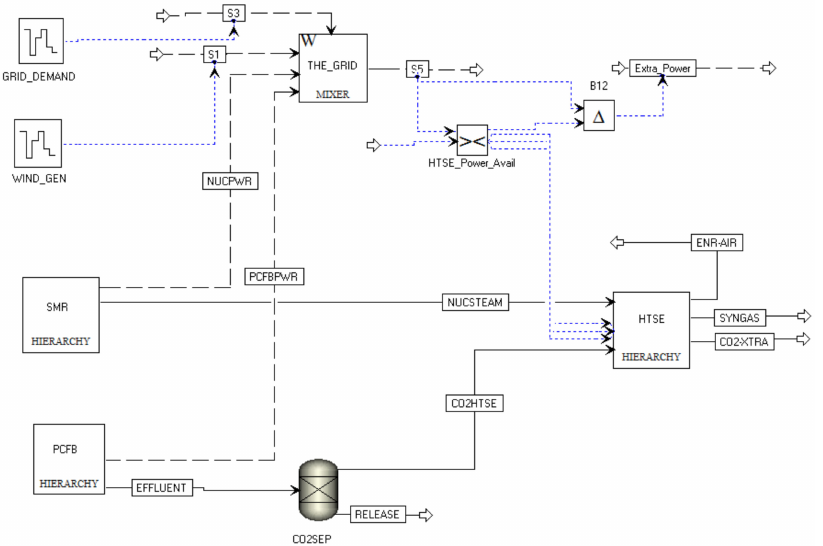
Figure 7. Coal–wind–nuclear hybrid energy system to produce low-carbon electric power plus chemicals or fuels [22]. Table 4. Cost analysis of coal–wind–nuclear hybrid energy system